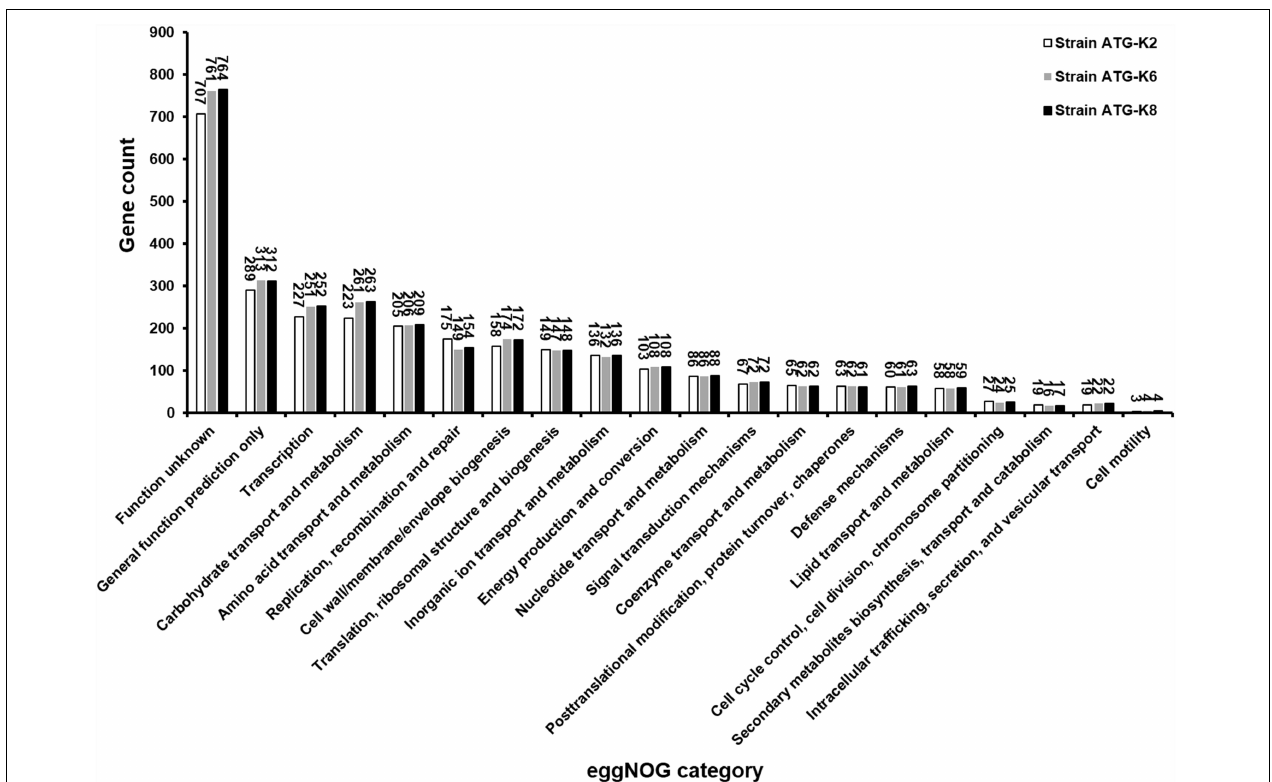
FIGURE 9 | Numbers of proteins encoded by Lactobacillus plantarum ATG-K2, L. plantarum ATG-K6, and L. plantarum ATG-K8 annotated with the corresponding eggNOG functional category.